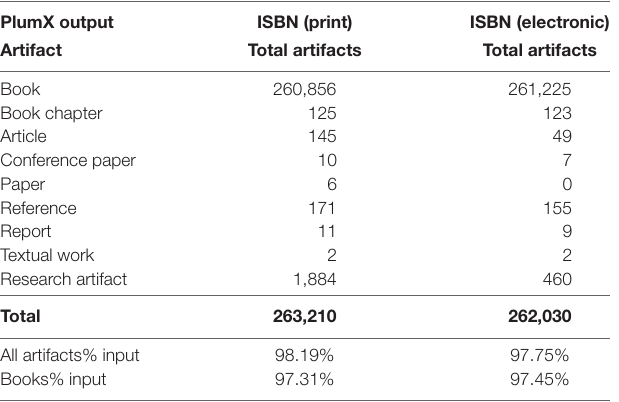
TaBle 2 | Artifact categorization in PlumX according to ISBN of the print or electronic version.